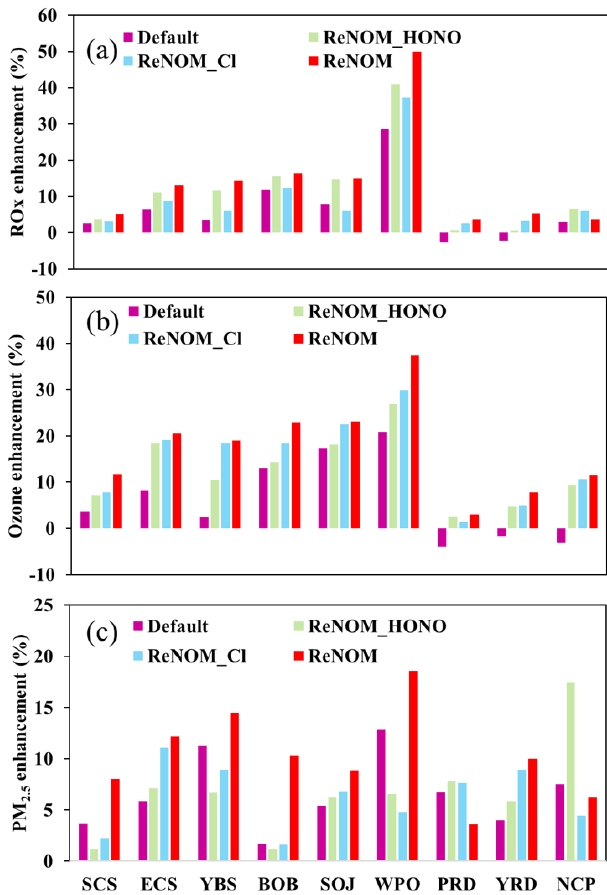
Figure 9. Contributions of ship emissions with different chemistry (Default, ReNOM_HONO, ReNOM_Cl, and ReNOM) to average mixing ratios of (a) daytime RO x , (b) ozone, and (c) PM 2 . 5